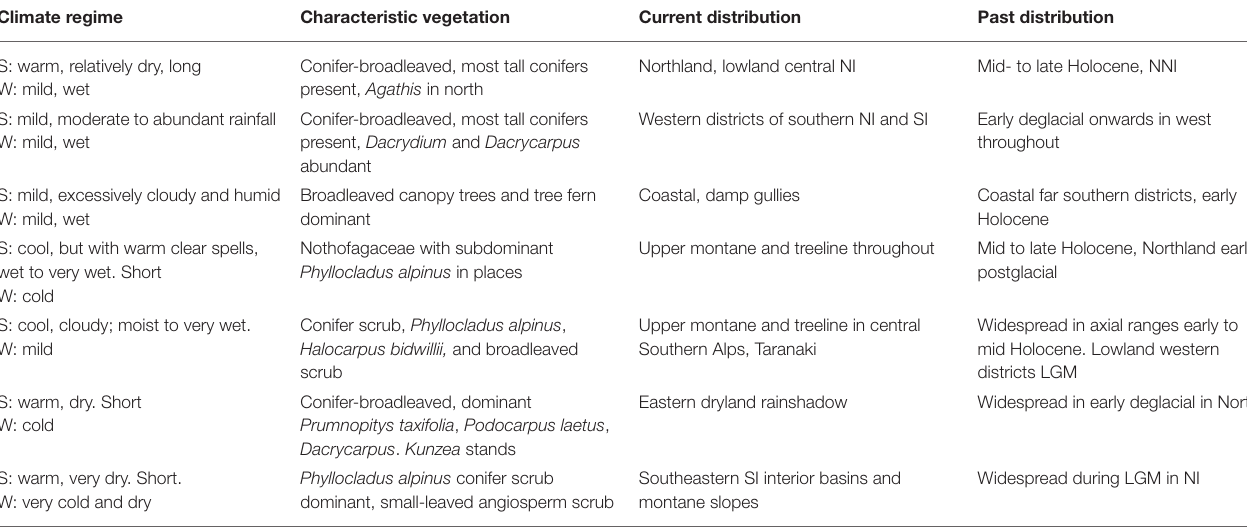
TABLE 2 | Climate regimes for major conifer associations past and